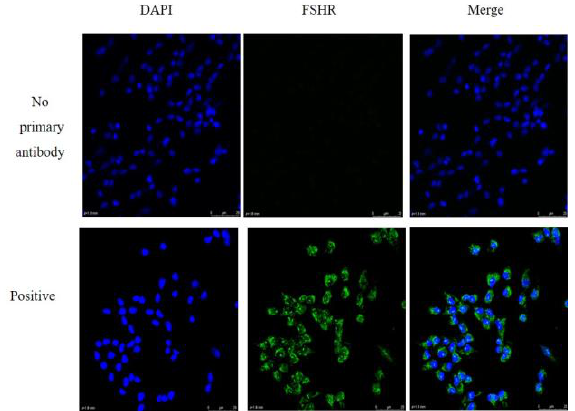
Figure 2. Fluorescence immunostaining for follicle-stimulating hormone receptor (FSHR) in granulosa cells. 4′,6-diamidino-2-phenylindole (DAPI )staining for nucleus (blue); immunoblotting for anti-FSHR cytoplasm (green); PBS for no primary antibody. Scale bar, 20 μm.